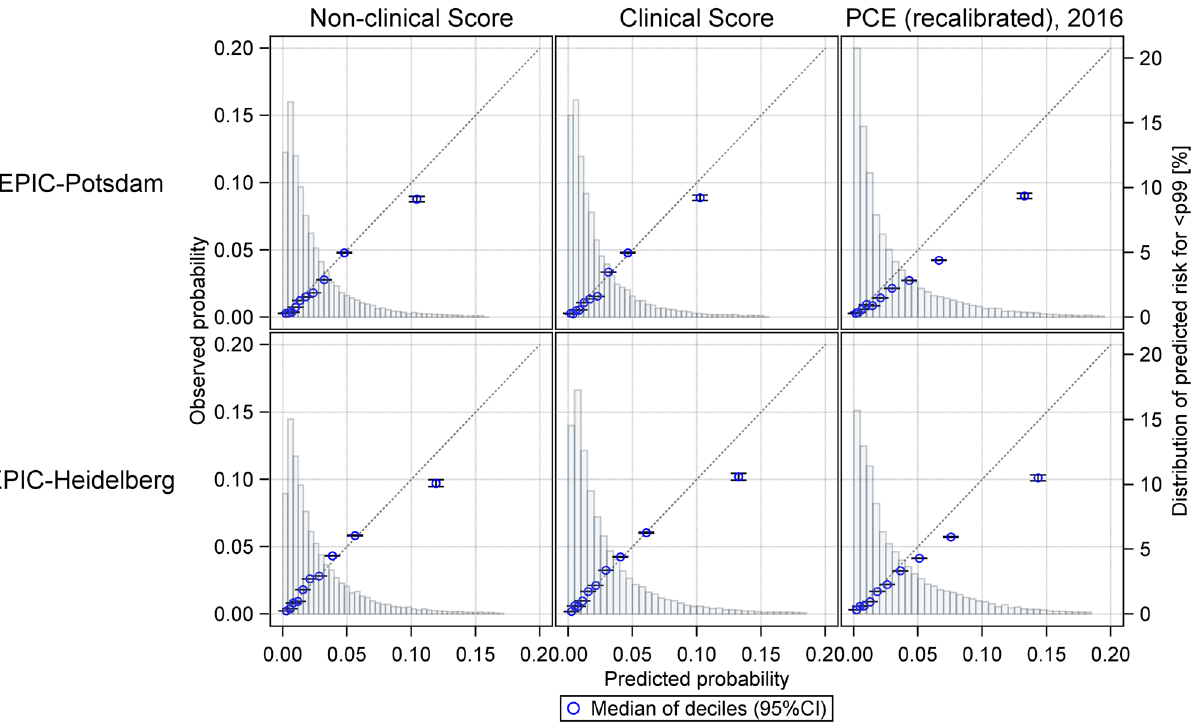
Figure 2. Calibration plots for the developed scores and the recalibrated PCE in EPIC-Potsdam and EPIC- Heidelberg. Observed and predicted CVD risk is grouped by deciles of predicted risk and plotted with the according 95% confidence interval (95%CI). Distribution of predicted risk up to the 99th percentile (p) is indicated in the background. EPIC, European Prospective Investigation into Cancer and Nutrition. PCE, Pooled Cohort